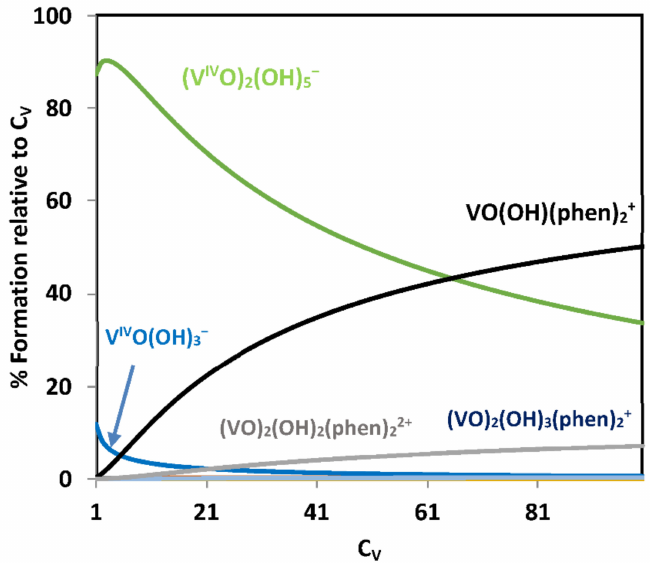
Figure 6. Species distribution diagrams in water at pH 7.0 for the system V IV O-phen [97] in the concentration range C V = 1 to 100 µ M (C V is the total V IV O concentration), with the molar ra- tio V IV O:phen of 1:2. The concentrations of the dinuclear species [(V IV O) 2 (phen) 2 (OH) 2 ] 2+ and [(V IV O) 2 (phen) 2 (OH) 3 ] + almost coincide. The diagrams were calculated using the HySS computer program [33] including the hydrolytic species [V IV O(OH)] + , [(V IV O) 2 (OH) 2 ] 2+ , [(V IV O) 2 (OH) 5 ] n − and [V IV O(OH) 3 ] −